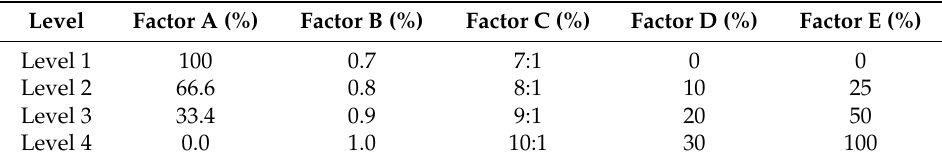
Table 2. Factors and levels.